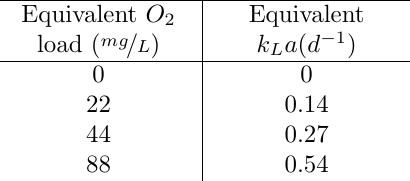
Table 3: Estimated k L a